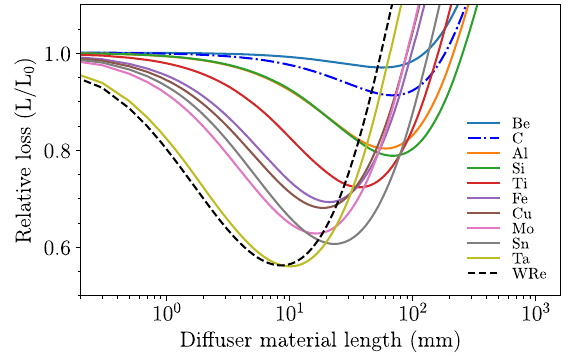
FIG. 5. Analytical calculation of the relative total loss for different diffuser lengths and a range of beam momenta, for a 0.2-mm-wide ES and 0.25-mm-wide WRe diffuser and 3.8° phase advance.